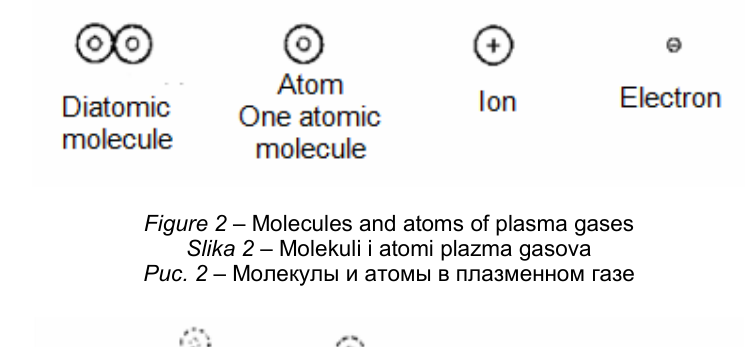
Рис . 2 – Молекулы и атомы в плазменном газе